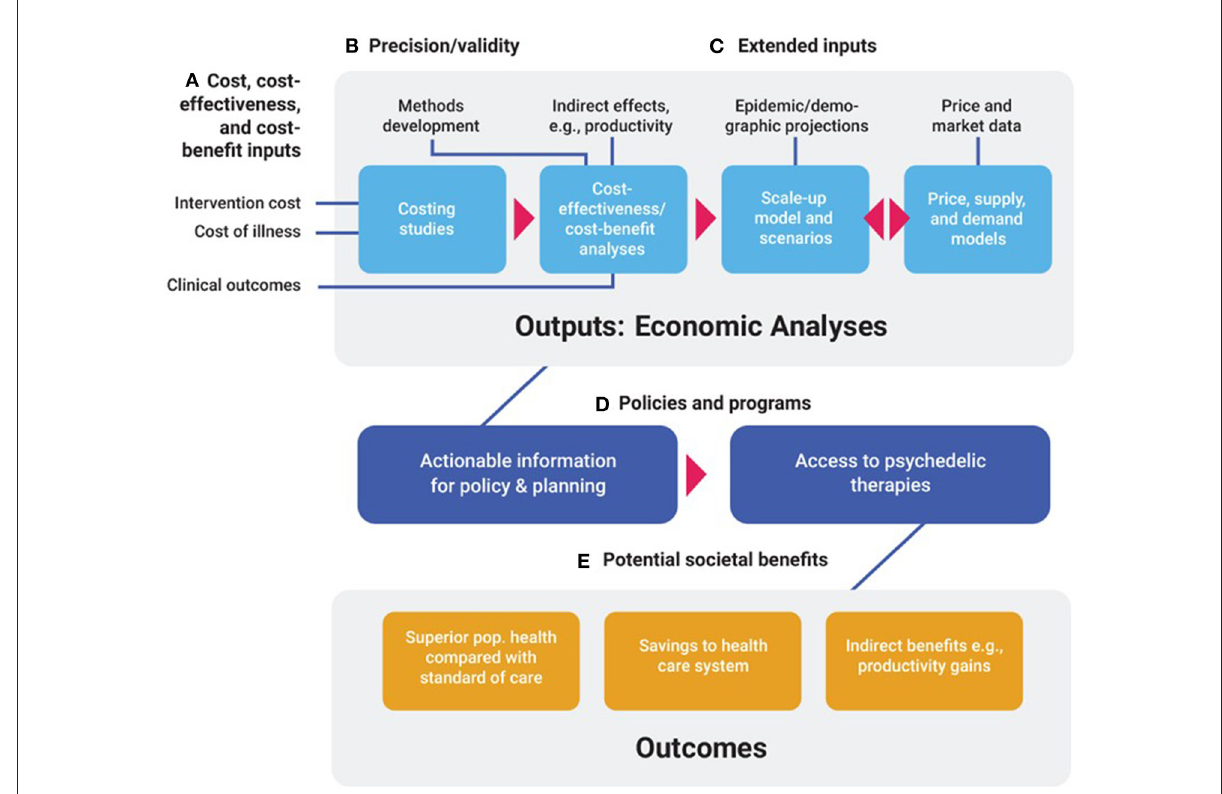
FIGURE1 Economic evaluations of psychedelic-assisted therapies: Inputs, outputs, outcomes. (A) Intervention costs, health care costs (Costs of illness), and clinical outcomes are broad classes of inputs needed for costing studies, and cost-effectiveness and cost-benefit analyses. (B) Precision and validity of economic models are enhanced by the development of methods that accurately portray costs and benefits of psychedelic therapies. (C) Extended inputs such as indirect economic effects; epidemic and demographic projections; and price and market data are required for cost-effectiveness analyses from a societal perspective, scale-up, and price models, respectively. These four major types of economic analytic outputs can then inform. (D) Policies and programs designed to deliver access to psychedelic therapies of demonstrated cost-effectiveness. Access to these therapies generate. (E) Societal benefits such as enhanced health outcomes, savings to the health care system, and indirect benefits such as productivity